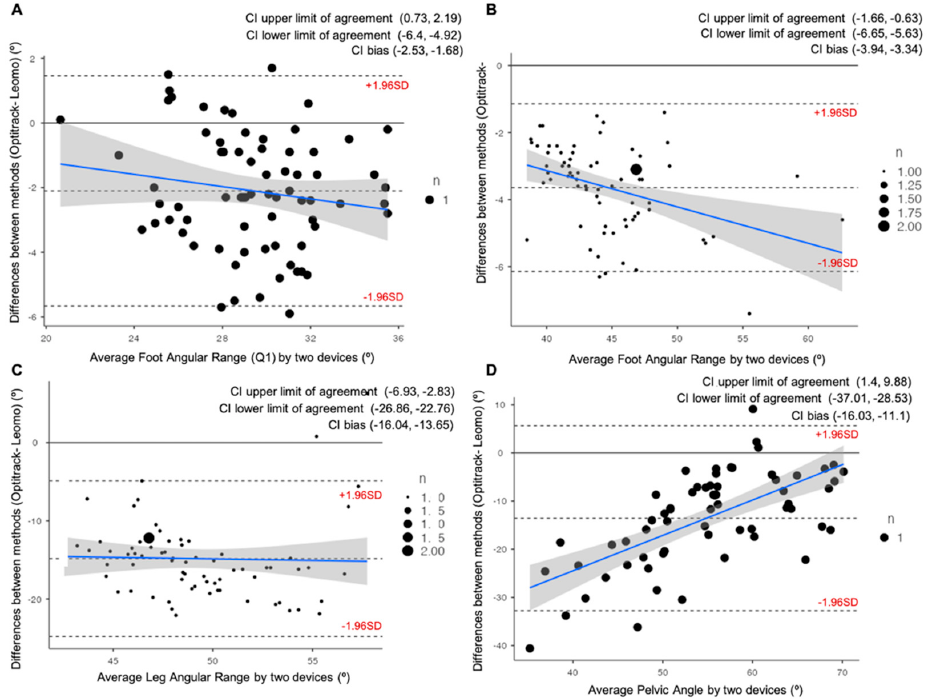
Figure 3. Bland–Altman plots representing comparisons between the Optitrack system and the Leomo system for four of the variables analyzed at VT1: ( A ) Average Foot Angular Range at first quartile of the pedaling cycle (Q1); ( B ) Average Foot Angular Range; ( C ) Average Leg Angular Range; ( D ) Average Pelvic Angle. The mean line represents the mean difference between the devices, with the upper and lower dashed lines representing the 95% limits of agreement (LOAs). 95% confidence intervals (CI) of the upper LOAs, lower LOAs, and bias are shown in the legend of each figure. The Bland–Altman plots during the VT2 intensity condition are provided in Figure 4. The behavior observed during the VT2 intensity condition was very similar to that ob- served in VT1, and all variables were overestimated ( p = 0.000) with the Leomo system by a mean of 1.7° ± 2.1° for FAR (Q1), 3.7° ± 1.3° for FAR, 15.1° ± 4.5° for LAR, and, finally, 12.8° ± 10.1° for Pelvic Angle, respectively.